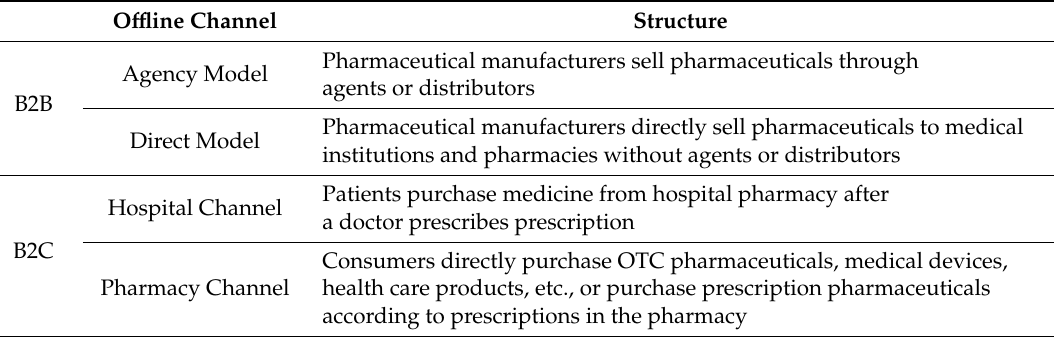
Table 1. O ffl ine pharmaceutical supply chain structure.